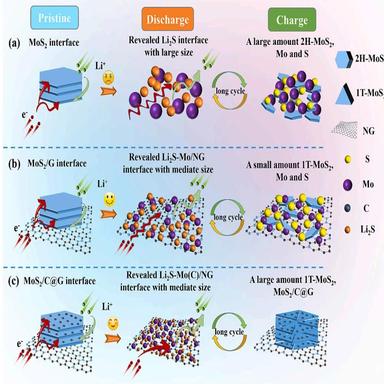
Schematic diagrams of the conversion reaction of (a) MoS2, (b) MoS2/G interface, and (c) MoS2/C@G interface.